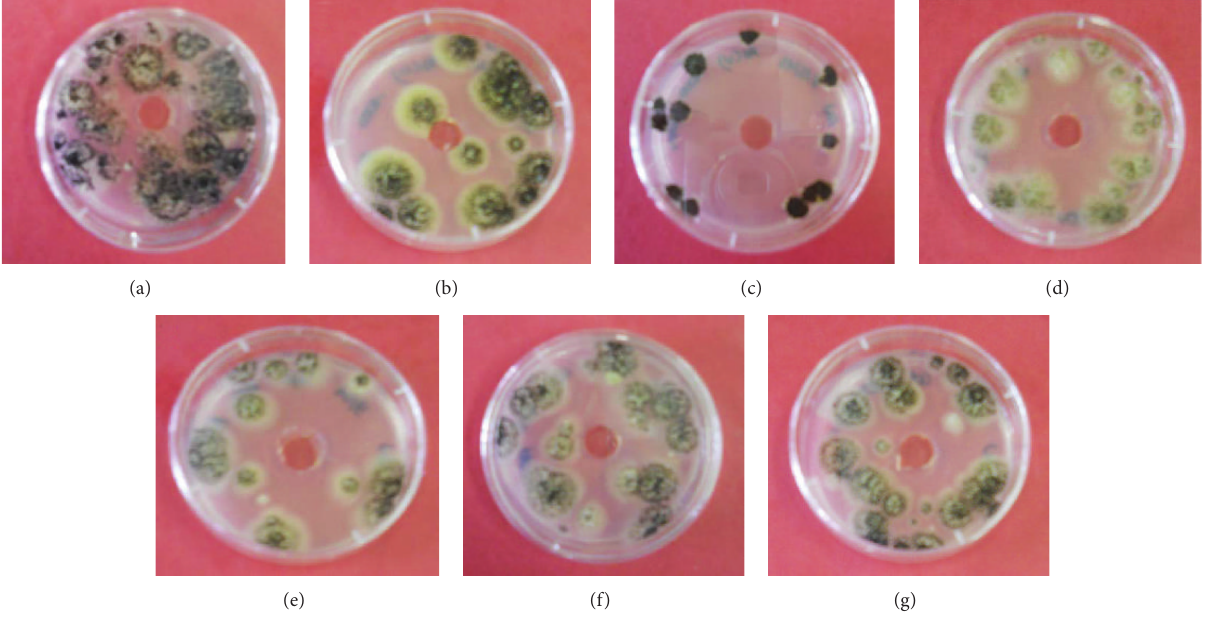
Figure 7: Visualization of the inhibition zones in the plate diffusion test for the investigation of the effect of (a) buffer solution, (b) 1000 ppm (13.35 mM) As(III), (c) 1000ppm (13.35mM) As(V), (d) 1000 ppm (8.90 mM) Cd(II), (e) 600 ppm (5.34 mM) Cd(II), (f) 400 ppm (3.56 mM) Cd(II), and (g) 100ppm (0.89 mM) Cd(II) on the growth of Aspergillus niger